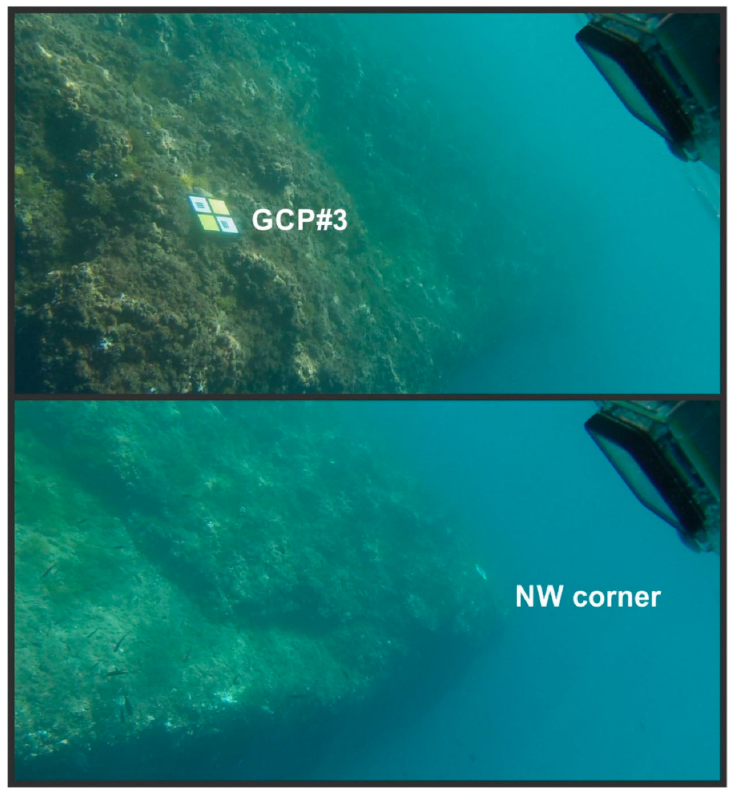
Figure 6. Photos of the underwater archaeological structure by